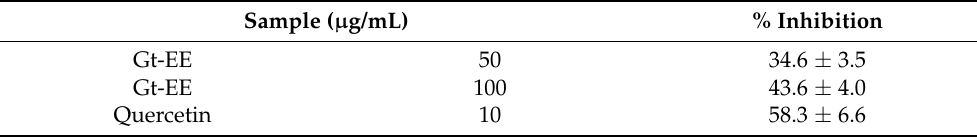
Table 2. Inhibition of 15-lipoxygenase activity by